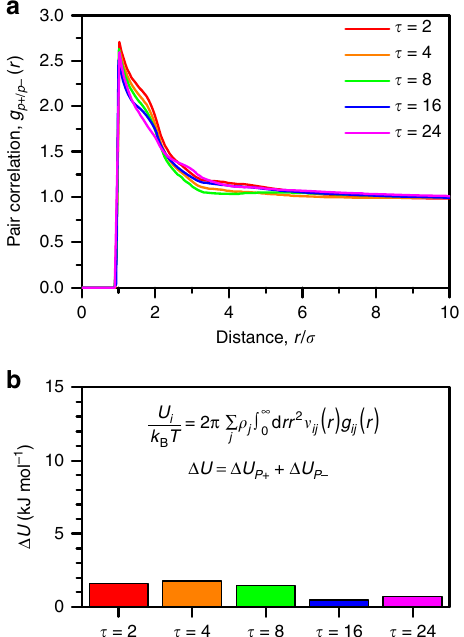
Fig. 4 Phase separating coacervate structure and energy shows no signi fi cant sequence effect. a Polycation/polyanion pair correlation function for the coacervate phase at various τ (boxed points in Fig. 2a). Correlations do not show strong dependence on τ . b Calculation of the change in electrostatic energy for the polycation (from g ( r ) such as in a ) show small, positive increases in energy during coacervation. This is qualitatively consistent with experimental data in Fig. 3